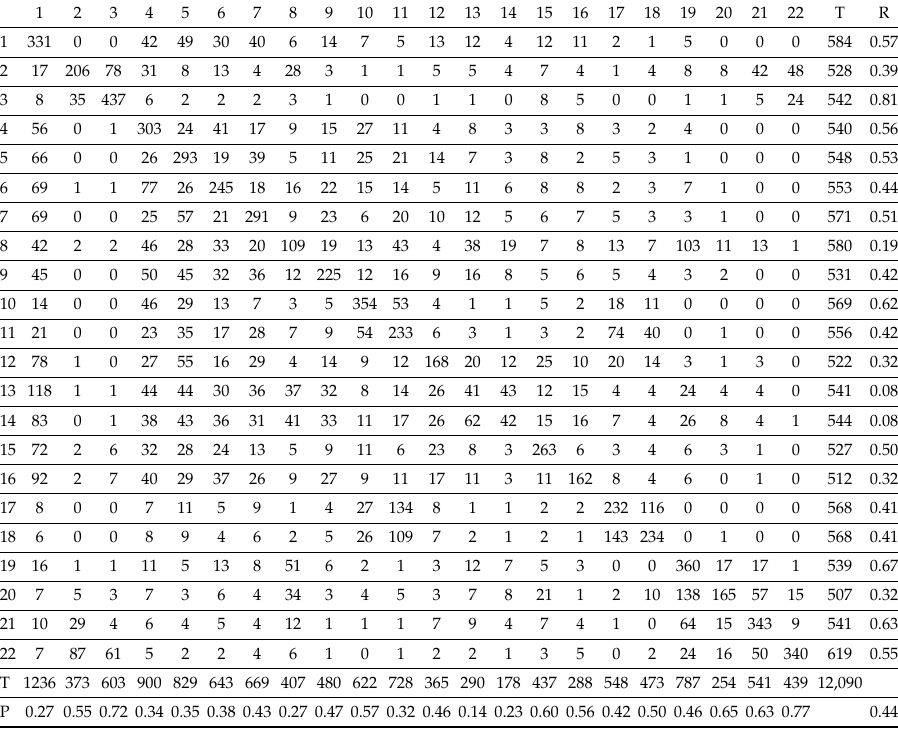
Table A3. The confusion matrix of the nearest-neighbor-based baseline with random attributes’ importance. The numbers are the average of 1000 times. The precision and recall were calculated based on these averaged numbers.